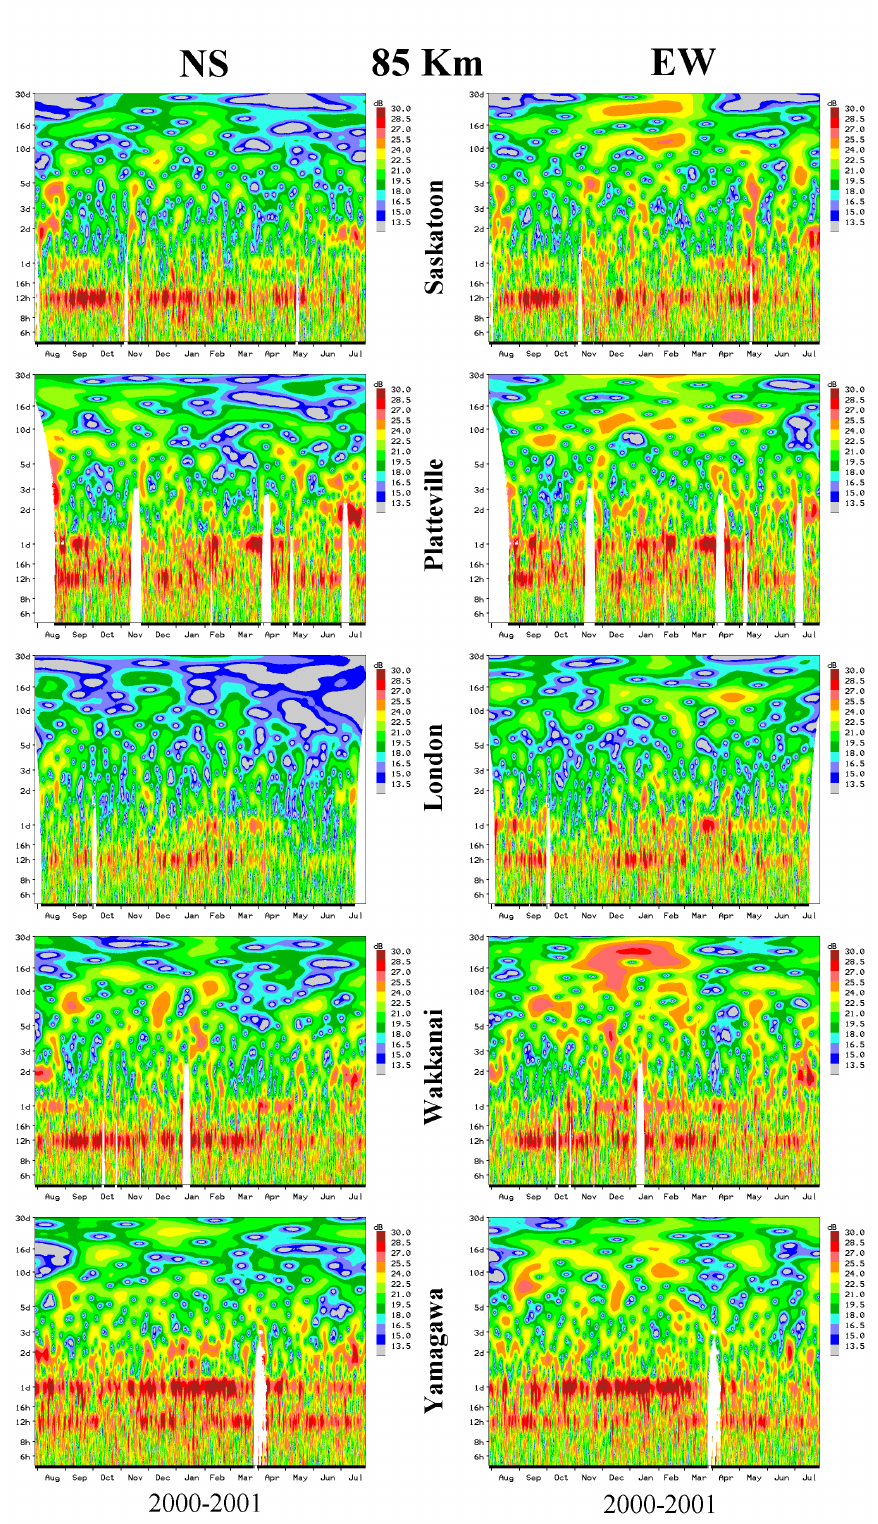
Fig. 2. Annual contours of wavelet intensities as functions of frequency and time for the zonal and meridional (EW, NS) components of the winds at four locations (London, Saskatoon, Platteville, Wakkanai, Yamagawa): the altitude is 85/86km. Analysis details are provided in Sect.